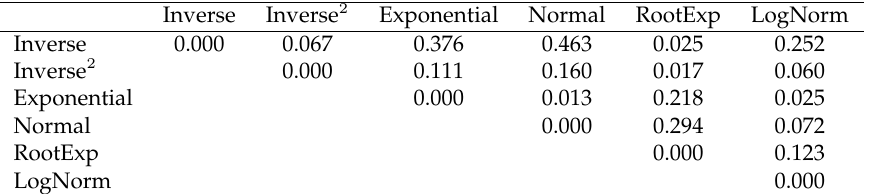
Table 2: Bhattacharyya distance ( D B ) comparing different functions for deriving proba- bilities from ∆ T i ( t ) in field-based time geography as applied to Scenario 3 ( D B = 0 for identical